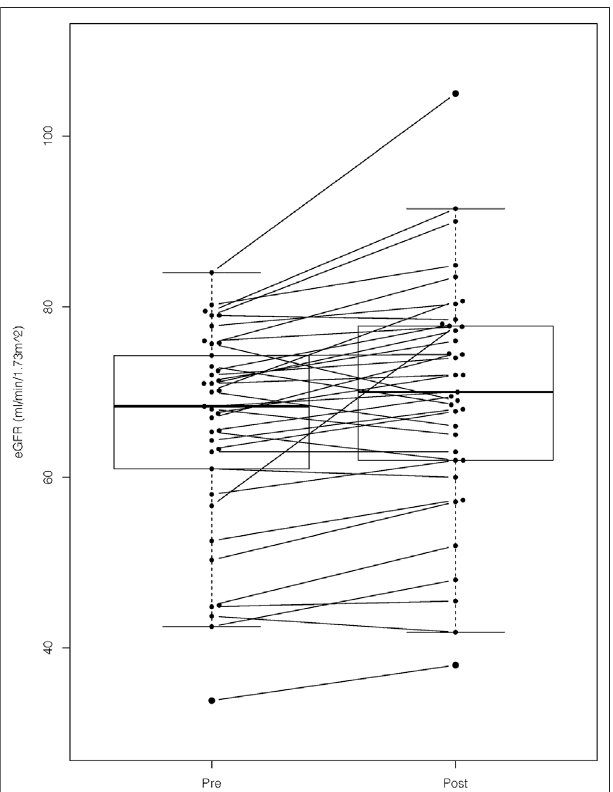
FIGURE2| TheeGFRvaluesbeforeandafterprescriptionofastragalus- containing preparations. We con fi rmed a statistically signi fi cant improvement of estimated glomerular fi ltration rate (eGFR) after prescription of astragalus- containing preparations. The mean eGFR value of the pre- and post- astaragalus prescription readings were determined by obtaining the mean value of all the available values 6 months before and after administering astragalus-containing preparations. We applied the paired t -test for this comparison ( p- value <